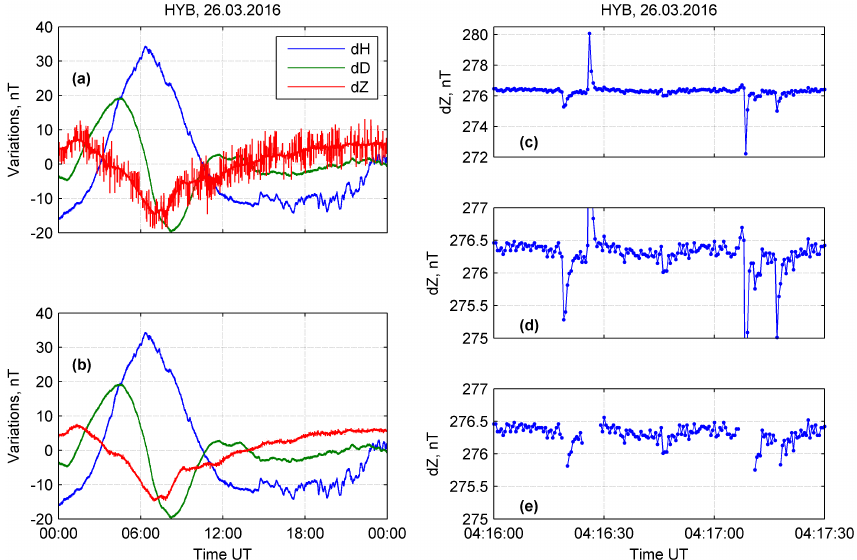
Figure 5. Example of frequent spikes at the Hyderabad observatory: (a) original daily records of variations d H , d D , d Z ; (b) the same of (a) , but after noise identification and removal in vertical component; (c) 1.5min fragment of daily d Z record, showing the detailed structure of the spikes; (d) results of noise clearing using a simple algorithm; (e) result of clearing using an algorithm based on wavelet